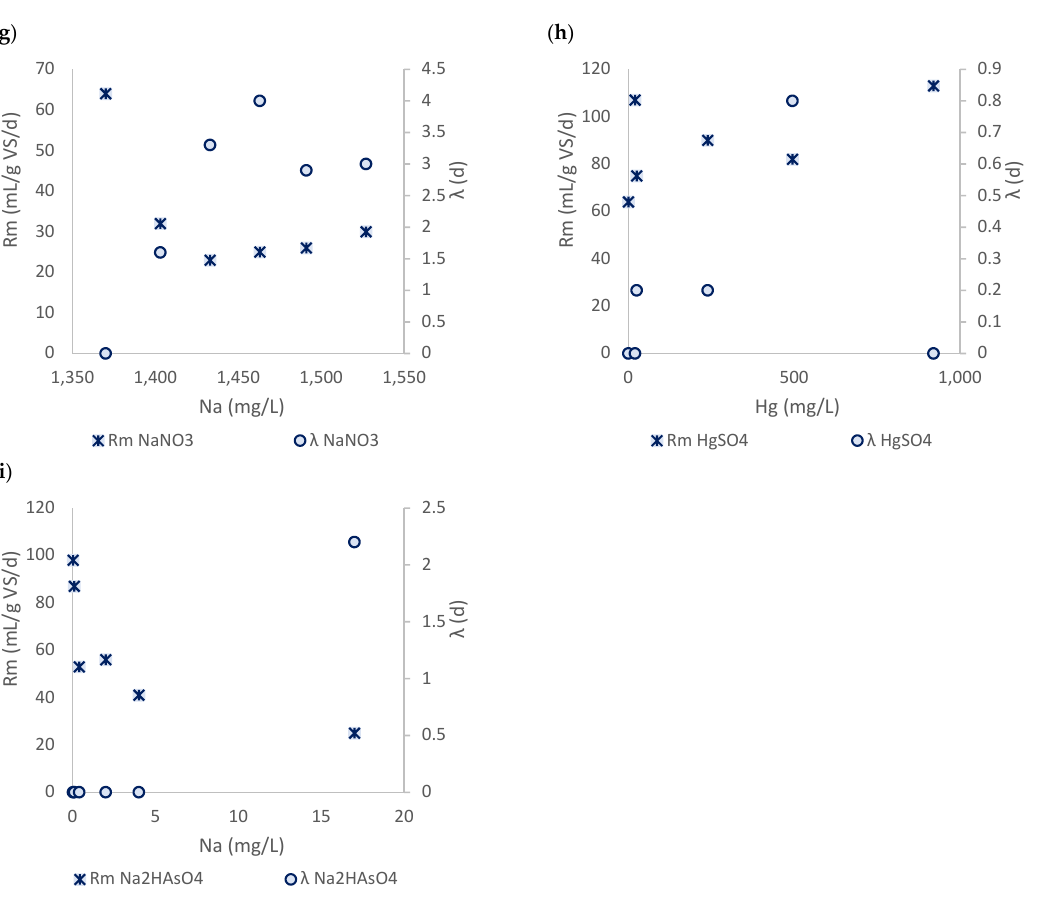
Figure 5. Results from Gompertz model for the biogas formation kinetics on the BMP experiments where TAN was increased adding ammonium sulphate and ammonium chloride ( a ), zinc was added as zinc sulphate and zinc chloride ( b ), copper was added as copper sulphate and copper chloride ( c ), aluminium was added with aluminium sulphate, aluminium chloride, and aluminium sulphate plus sodium hydroxide ( d ), pH was modified using hydrochloric acid ( e ), sodium was added as sodium sulphate, sodium chloride ( f ), and sodium nitrate ( g ), mercury was added as mercury sulphate ( h ), and arsenic was added as sodium arsenate ( i ).